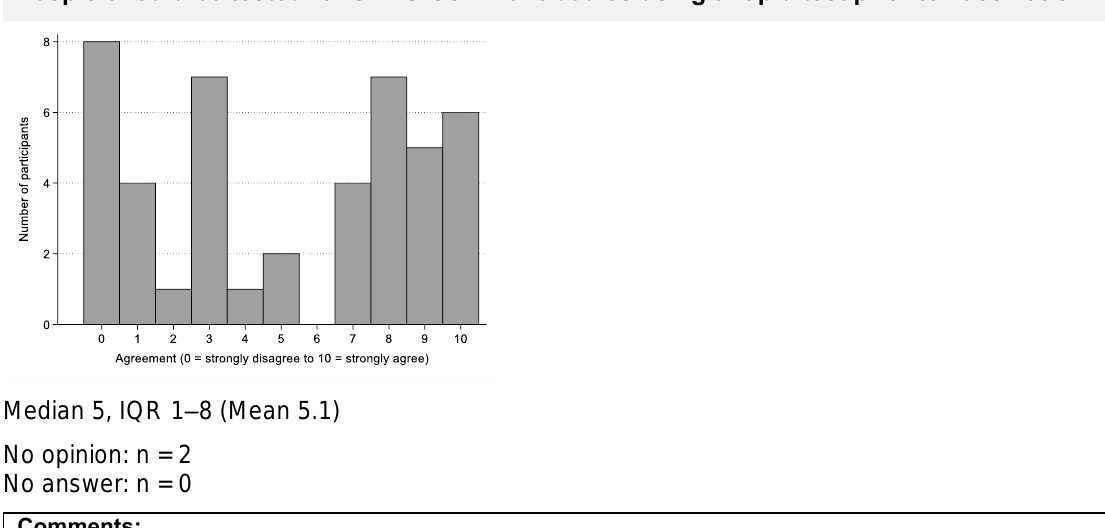
10. Background: As of September 2020, seroprevalence of SARS-CoV-2 antibodies in the general population varies greatly by canton, between 3% in Zürich and 11% in Geneva. Seroprevalence among health professionals is only marginally